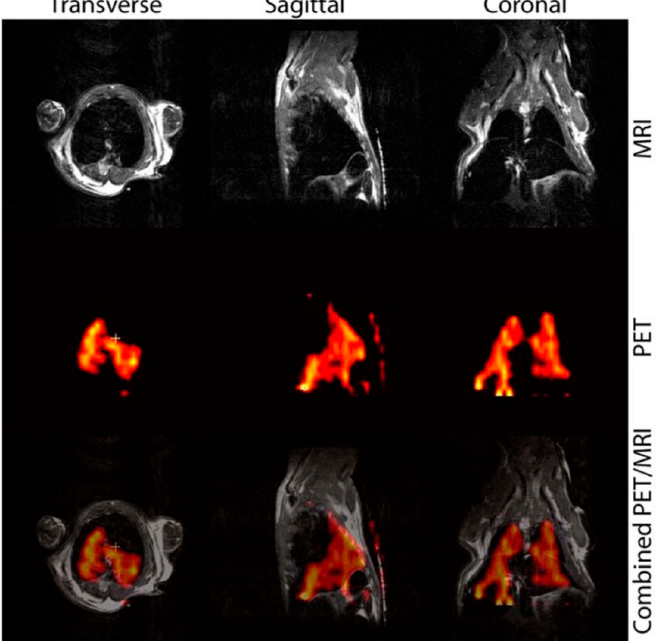
Figure 8. Simultaneous PET/MR images of a mouse, which has been intravenously injected with 11 C based RIONs; top row: the MR images indicate a significant darkening of the liver due to the presence of 11 C based RIONs; middle row: the radioactive signal is a result of the decay of 11 C radionuclide and indicates the presence of 11 C based RIONs in the liver; bottom row: fused PET/MR images (Used with permission of Royal Society of Chemistry, from [64]; permission conveyed through Copyright Clearance Center,